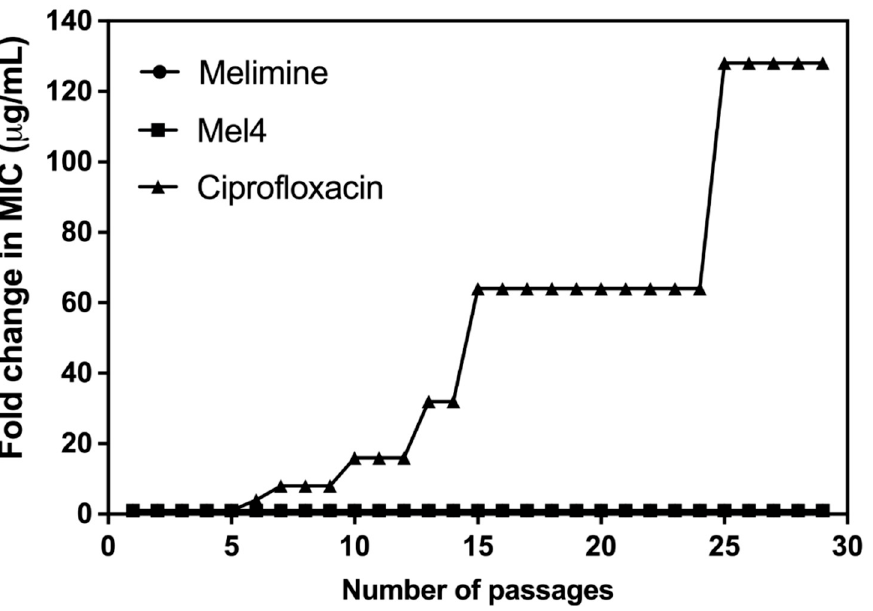
Figure 2. Increase in MIC values of ciprofloxacin, melimine or Mel4 against S. aureus ATCC 25923 after exposing bacteria at their sub-MIC for 30 consecutive days. The MIC values of melimine and Mel4 did not change over time and overlap at the bottom of the figure.